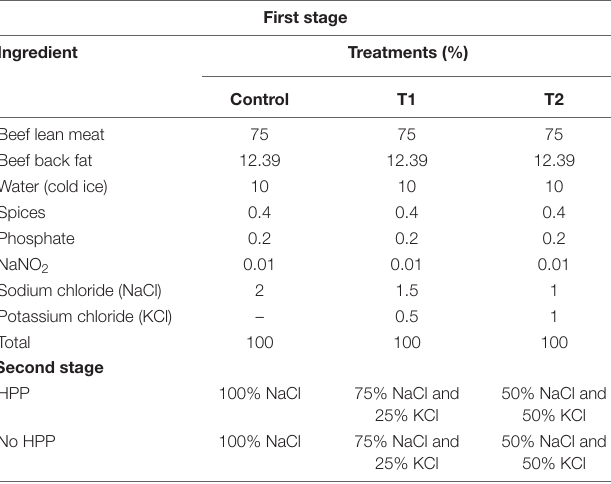
TABLE 1 | Percentages of sodium chloride and potassium chloride used in the formulation of beef